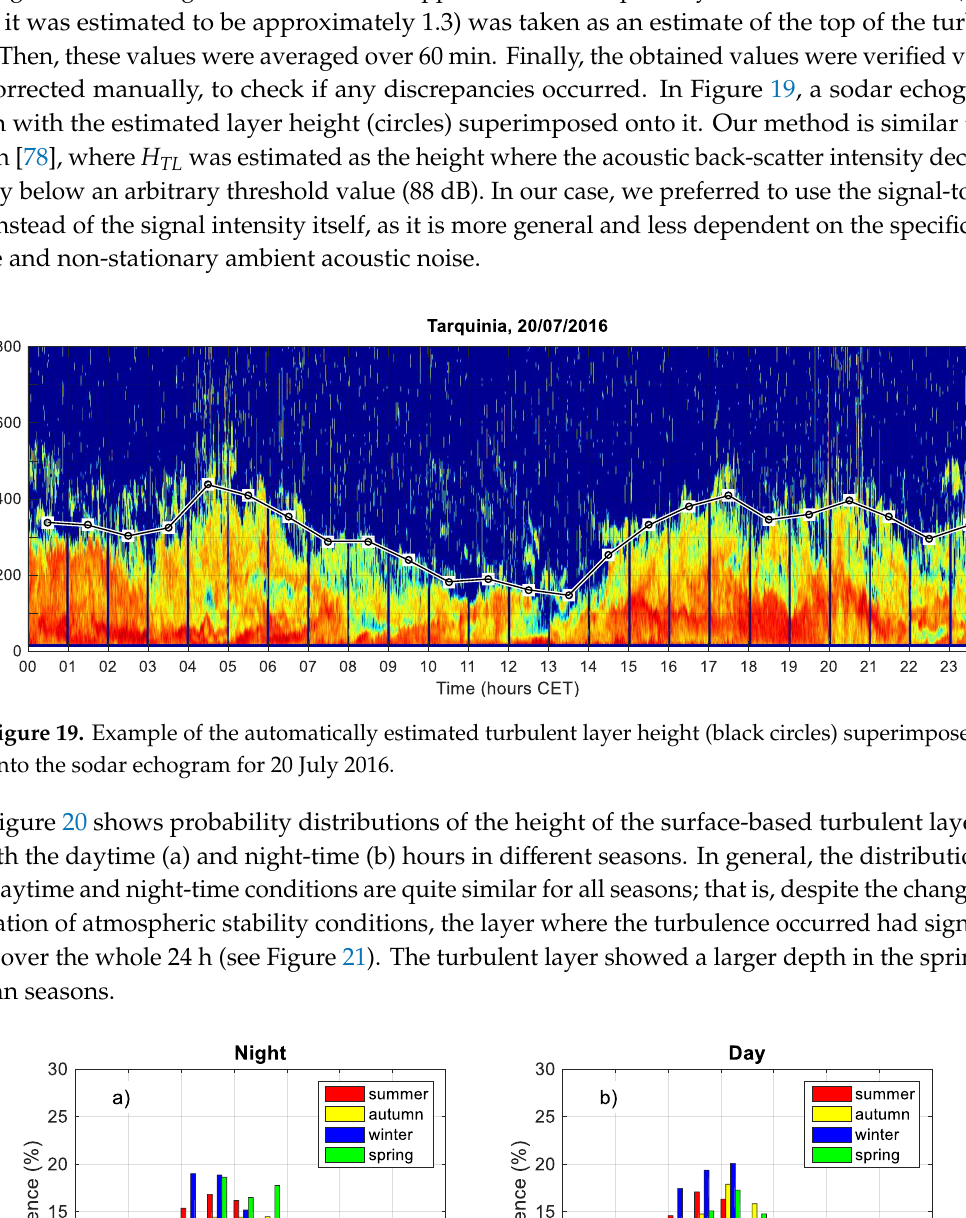
for ( a ) night-time and ( b ) daytime hours for TL